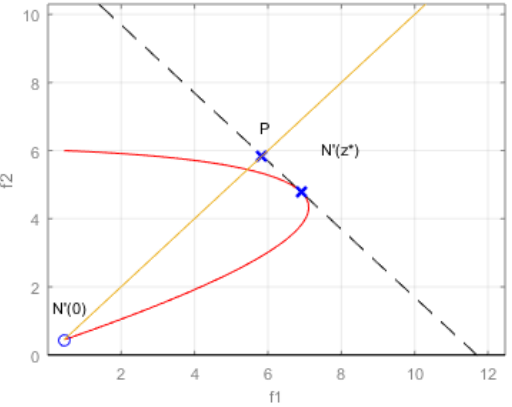
Figure 8. Purely coopetitive sharing P µ .